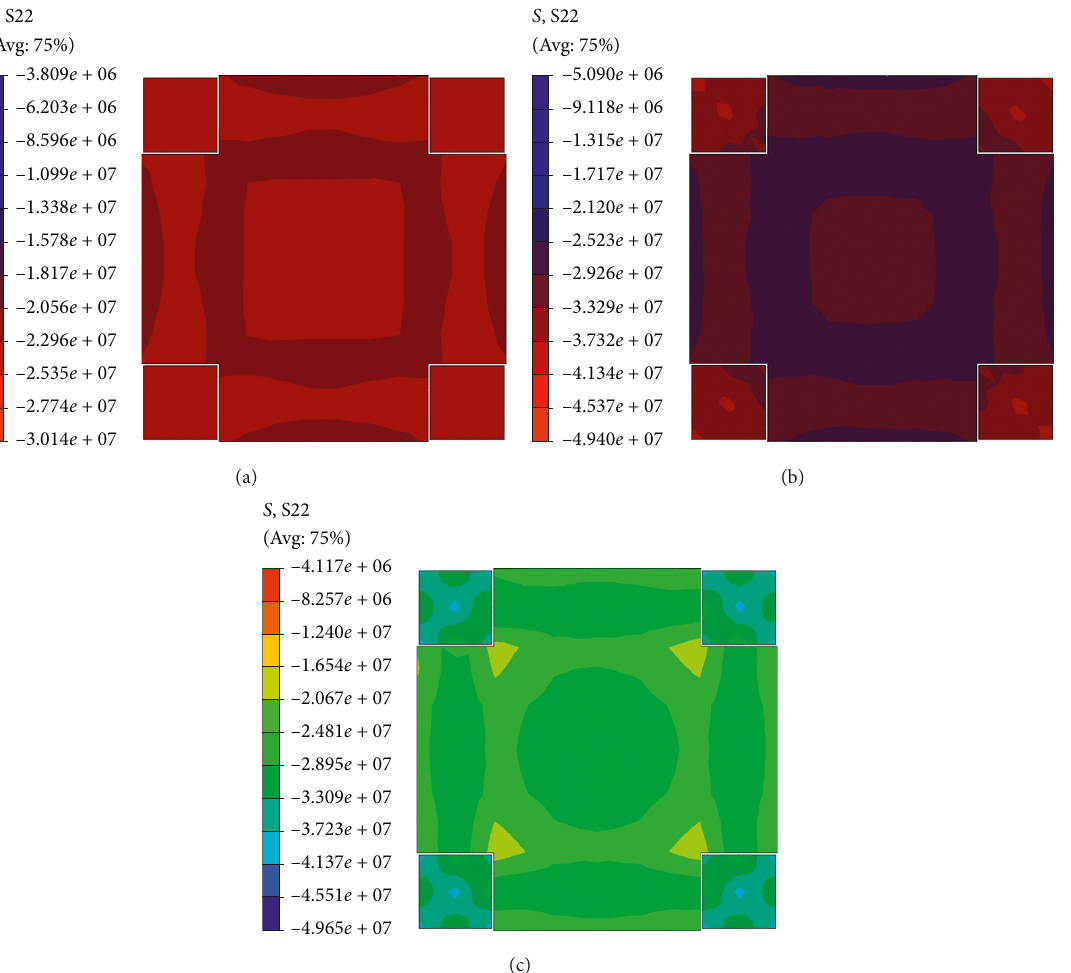
Figure 13: Stress contours of the ISSCC column in midsections under (a) the yield load, (b) the ultimate load, and (c) the ultimate load of